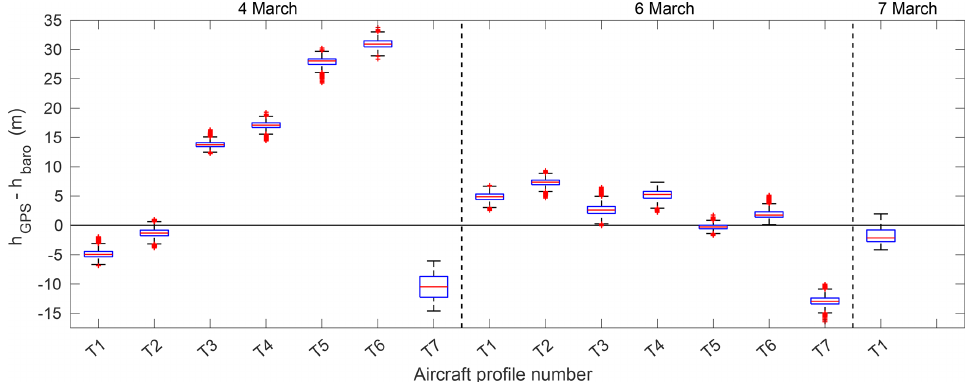
Figure 2. Distribution of the differences between the aircraft’s height measured by GPS ( h GPS ) and the corrected pressure altitude ( h baro ) for each aircraft profile (see Table 1). Red lines show the median, the boxes are bounded by the upper and lower quartiles, the whiskers include the interval of approximately 99.7% of the values, and red crosses denote